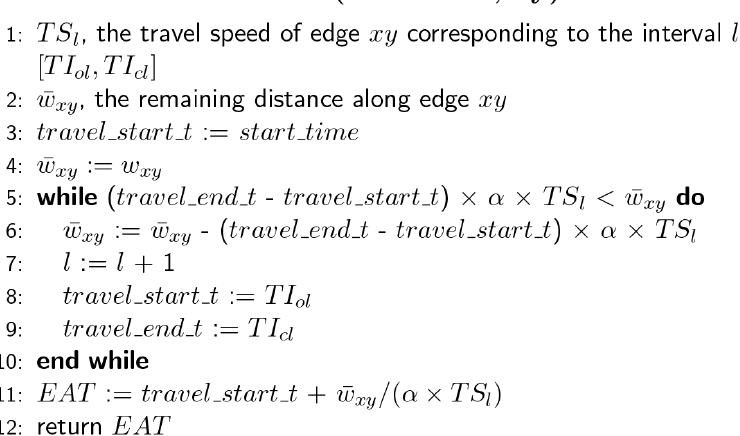
Figure 5. The function for estimating arrival